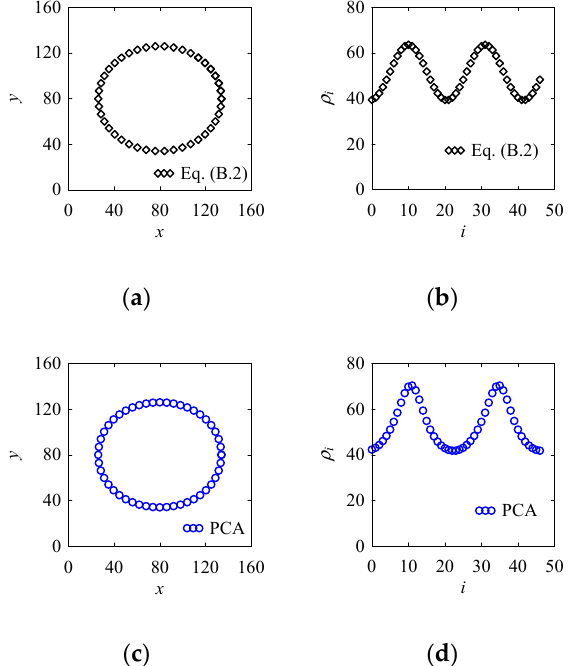
Figure 12. Ellipse shapes and their radii of curvature. ( a ) Point cloud of an ellipse modeled by a parametric equation; ( b ) radius of curvature of ( a ); ( c ) point cloud of an ellipse modeled by the PCA; ( d ) radius of curvature of ( c ).